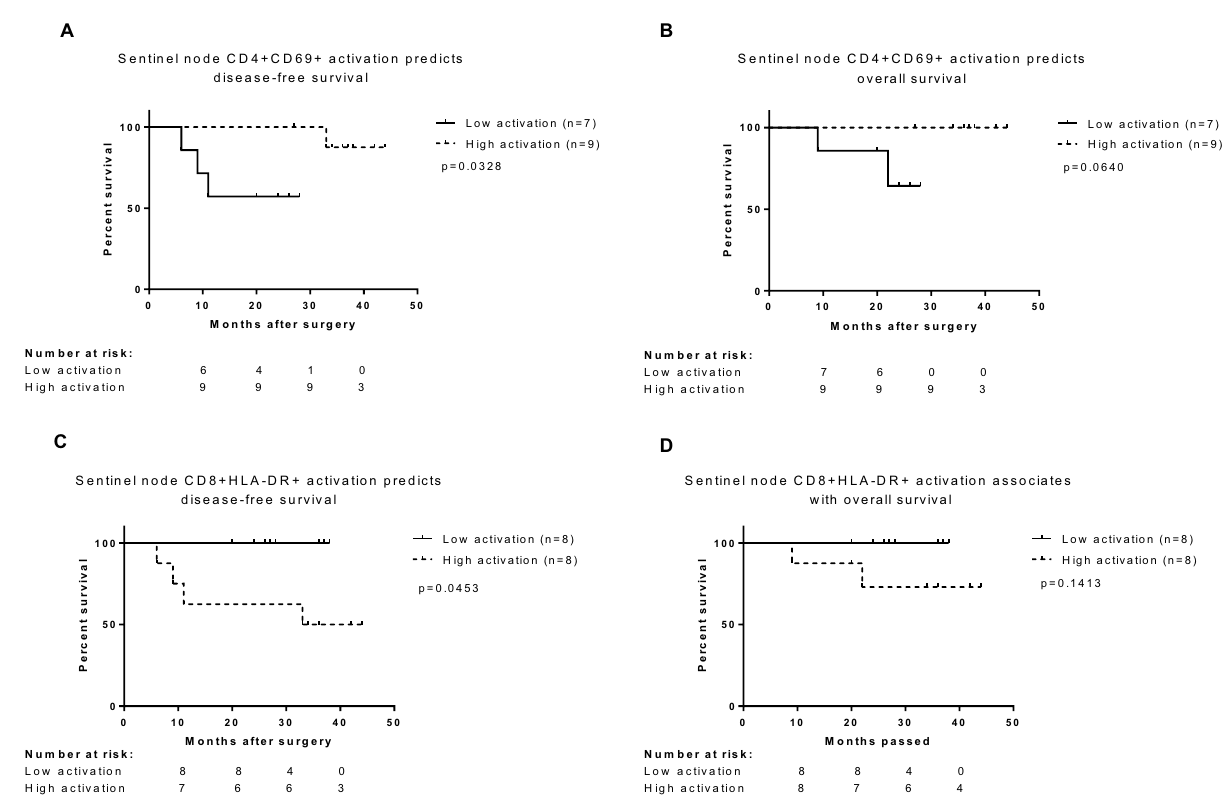
Figure 4. Kaplan–Meier analysis of DFS and OS according to CD4+ CD69+ ( A , B ) and CD8 + HLA-DR+ ( C , D ) percentage in sentinel nodes. The median value of 37.5% for CD69+ and 25.2% for HLA-DR+ was a priori chosen as the cut-off for separating sentinel nodes with low and high expression of aforementioned surface markers. The p-value for the difference between the two curves was determined by the log-rank